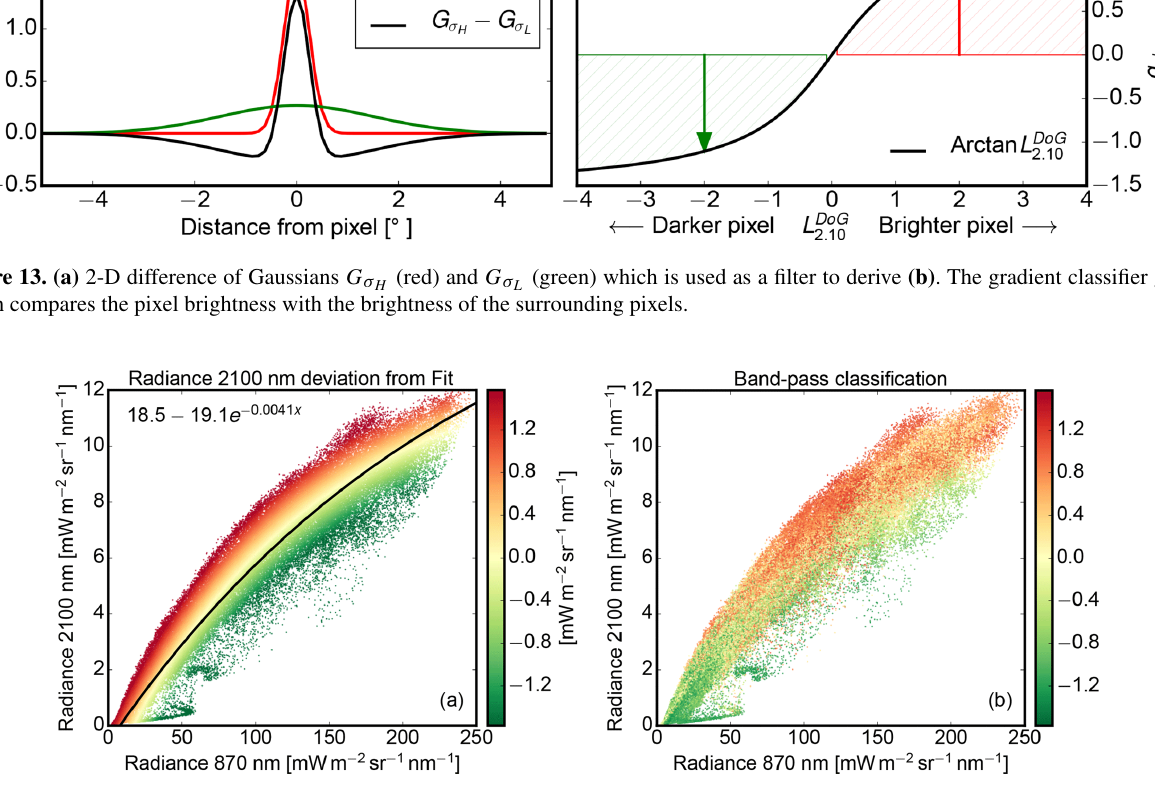
Figure 14. (a) Two-wavelength diagram for the MYSTIC calculation shown in Fig. 5 but with a fixed effective radius of r eff = 8µm. (b) Result of the gradient classifier g class applied to the same